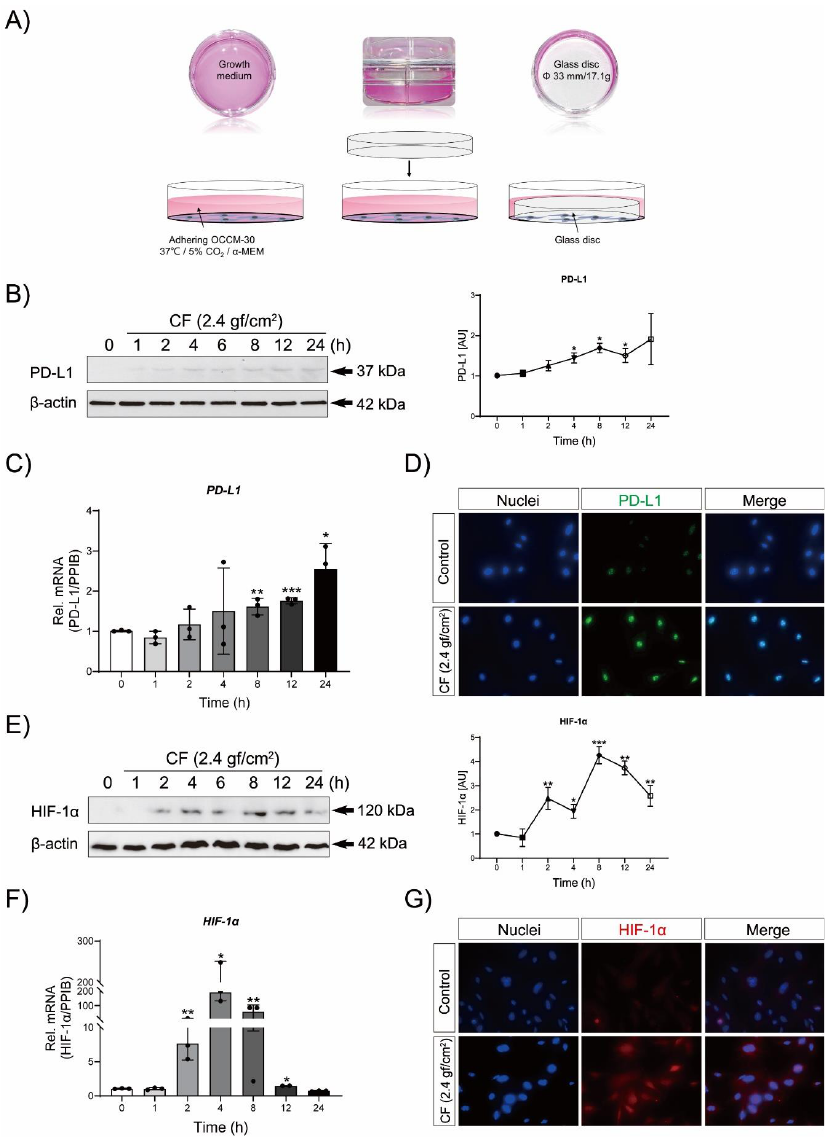
Figure 2. Up-regulation of PD-L1 and HIF-1 α in OCCM-30 cells in response to compressive force. Cementoblast cultures were compressed by orthodontic force (2.4 gf/cm 2 ) after various time periods (1, 2, 4, 6, 8, 12 and 24 h). ( A ) Photographs of the physiological cell culture conditions and the cells stimulated by compressive force (CF). Schematic model of the in vitro method used for CF application. ( B , C ) The PD-L1 protein expression was determined by immunoblot and its localization was detected by IF staining. ( D ) RT-qPCR quantification of PD-L1 gene expression in OCCM-30 cells cultured under compressive force for indicated time points. ( E , F ) The HIF-1 α protein expression was determined by Western blot. The HIF-1 α localization was assessed by IF method. ( G ) RT-qPCR quantification of HIF-1 α gene expression in OCCM-30 cells cultured under compressive forces for indicated time. The relative